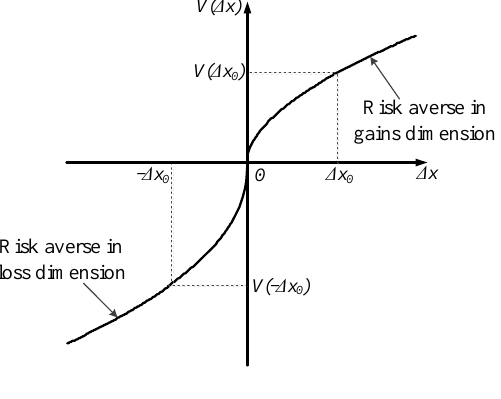
Figure 1. Prospect utility curve.